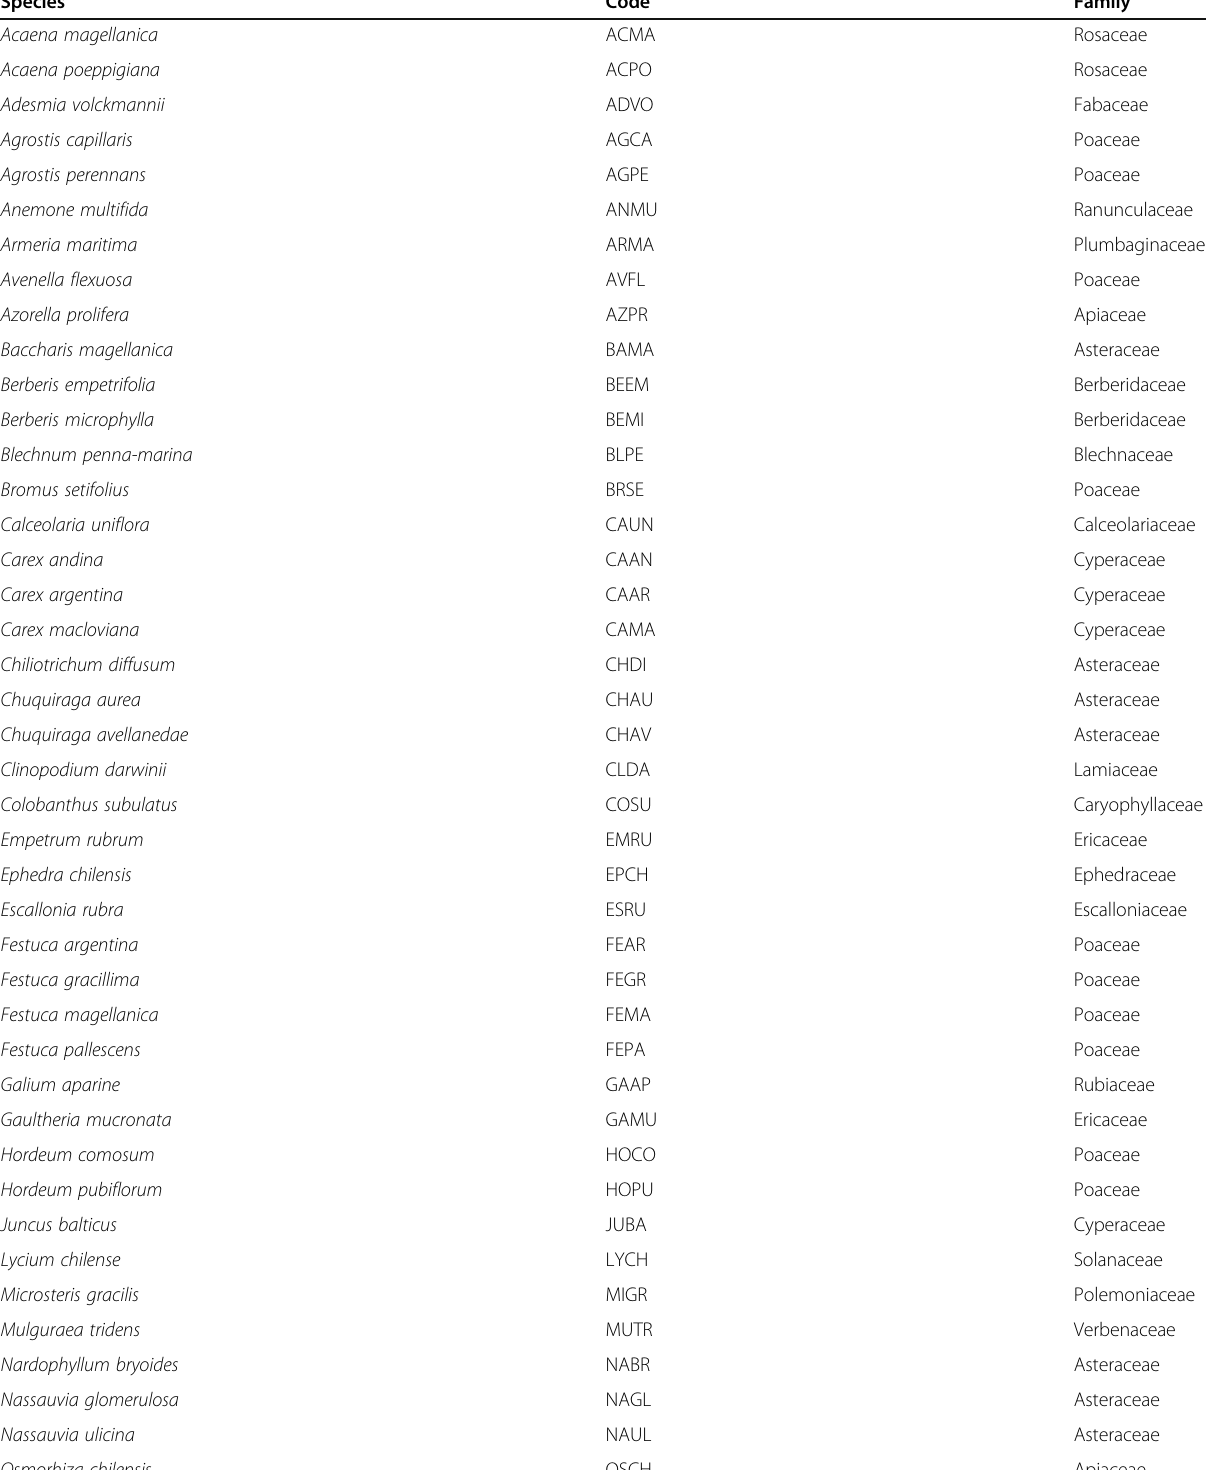
Table 2 Codes and taxonomy of the vascular plant species selected for the modelling of potential habitat suitability in Santa Cruz Province